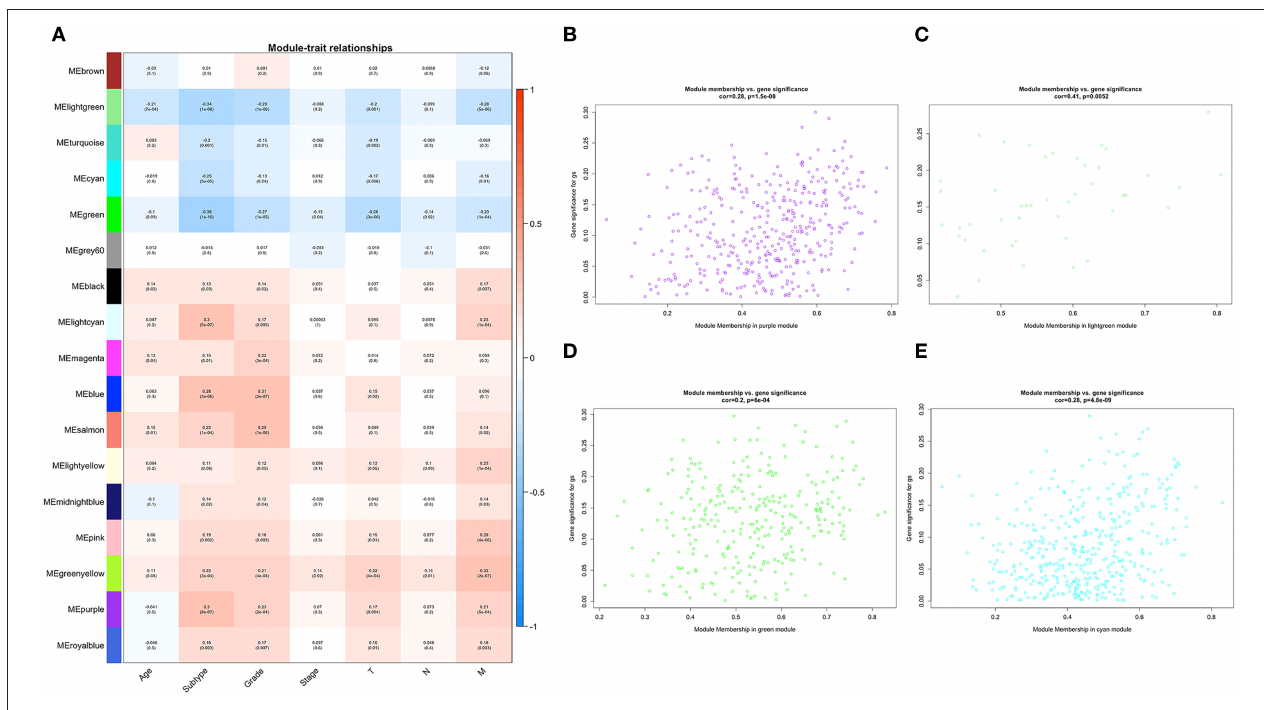
FIGURE 3 | Relationships between WGCNA identified modules and clinical traits. (A) Heat map of the correlation among all 17 modules and seven selected clinical traits including age, tumor subtype (papillary and non-papillary), tumor grade (low grade and high grade), tumor stage (stage II and stage III-IV), tumor T stage (T2 and T3-4), tumor N stage (non-metastasis and metastasis), and tumor M stage (non-metastasis and metastasis). (B) Scatterplot of the relationship between gene significance (GS) and module membership (MM) in the purple module, (C) in the light green module, (D) in the green module, and (E) in the cyan